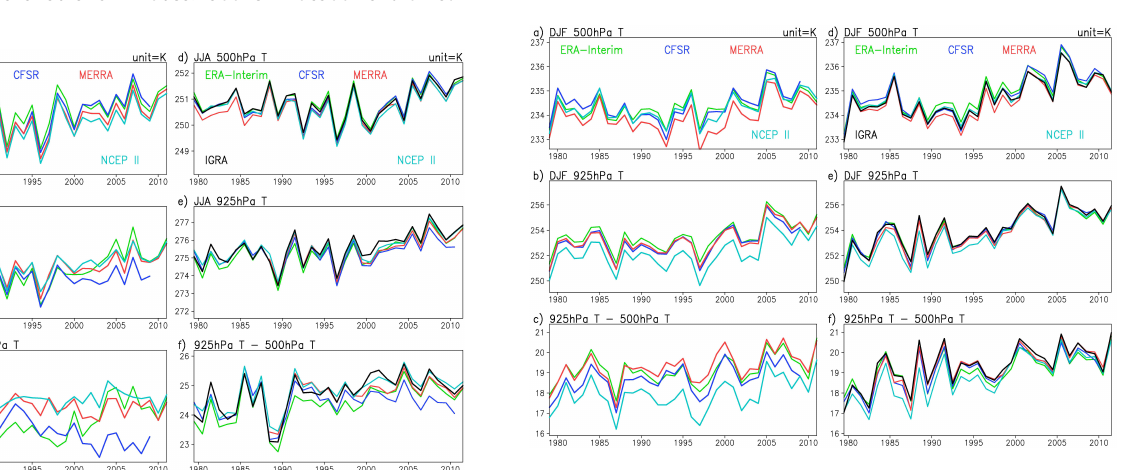
Fig. 6. Same as Fig. 3 except for the DJF (December, January and February)